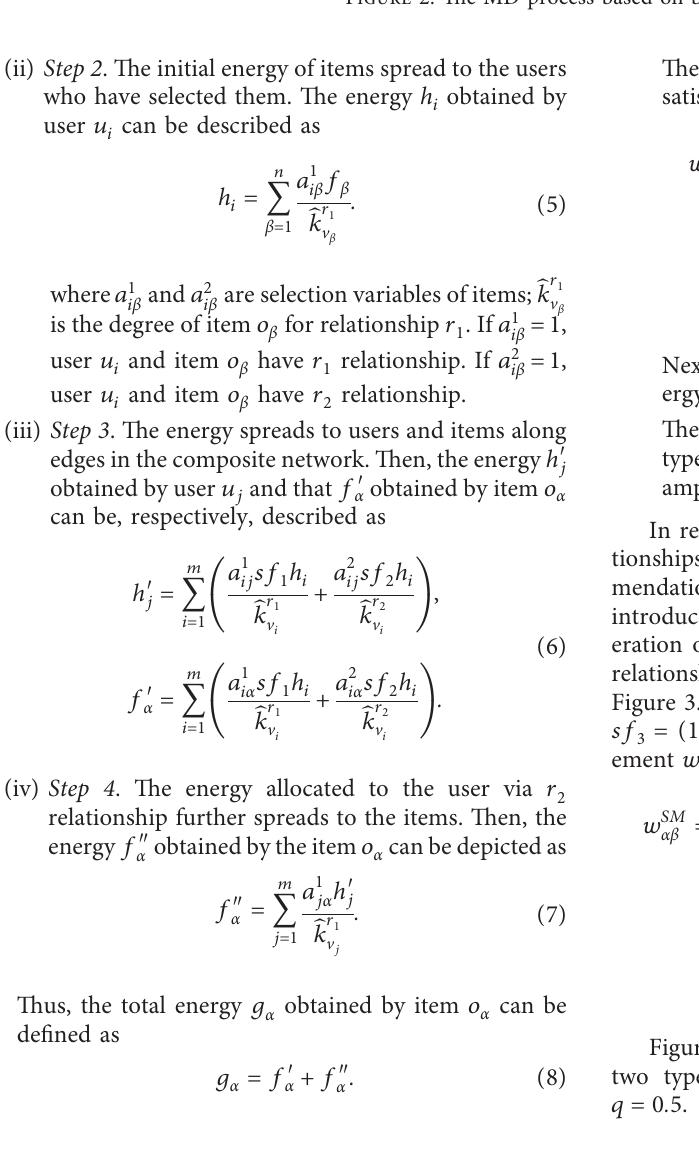
Figure 2: The MD process based on bipartite